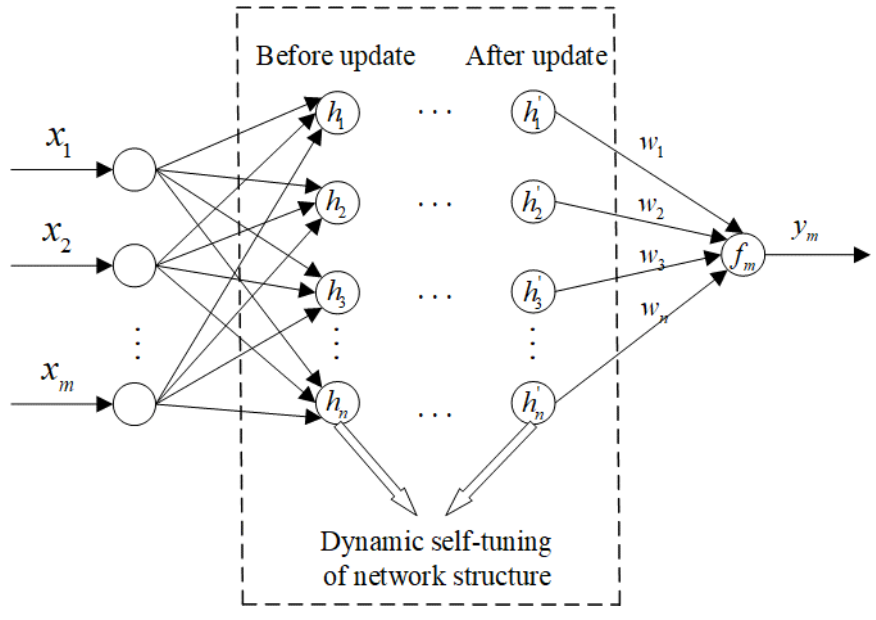
Figure 6. Network structure of ESST-RBFNN.